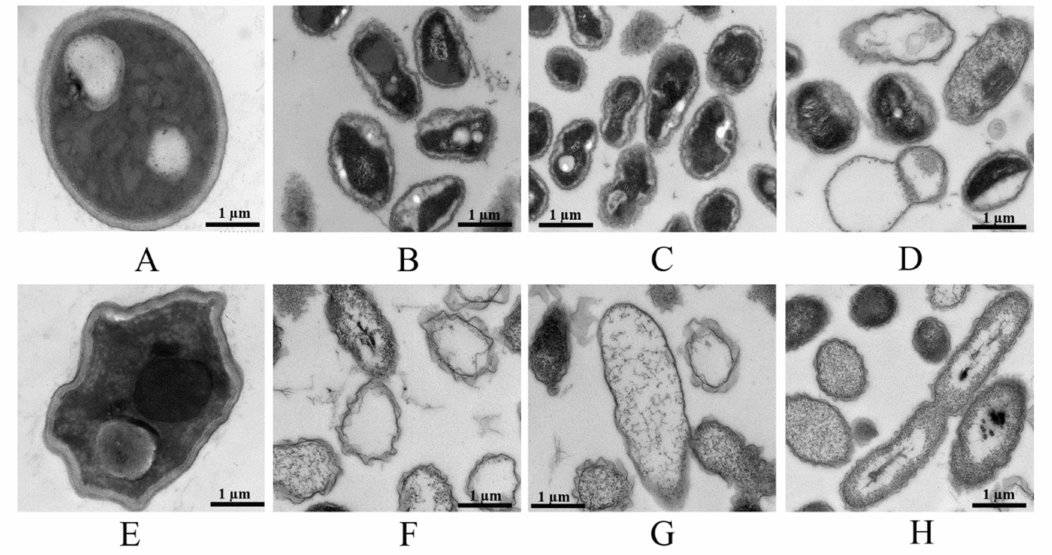
Figure 7. TEM images of structural changes in the morphology of F. graminearum induced by fungicides, GO–fungicides and GO. Mycelia of the control ( A ), GO–treated ( E , 100 µ g mL − 1 ), Man–treated ( B , 20 µ g mL − 1 ), Man–GO–treated ( F , 20 µ g mL − 1 ), Cyp–treated ( C , 100 µ g mL − 1 ), Cyp–GO–treated ( G , 100 µ g mL − 1 ), Dif–treated ( D , 200 µ g mL − 1 ) and Dif–GO–treated ( H , 200 µ g mL − 1 ) F. graminearum ,